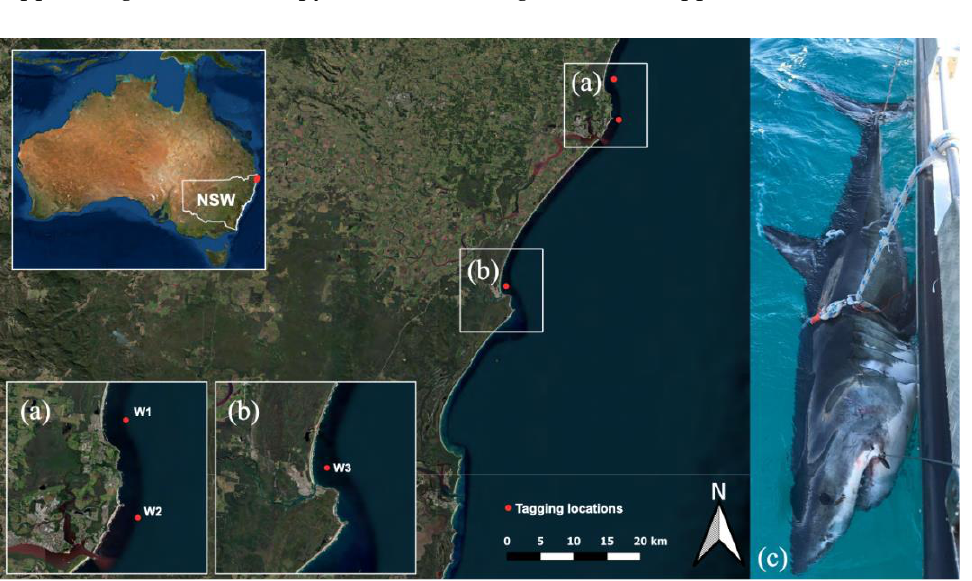
Figure 1. Location of tagging sites (red dots) on the northern New South Wales coast of eastern Australia. ( a ) Lennox Head, tagging site of white shark 1 (W1) and Ballina, tagging site of white shark 2 (W2), ( b ) Evans Heads, tagging site of white shark 3 (W3), and ( c ) W1 secured to the side of the vessel during tagging procedure (image provided by the New South Wales Department of Primary Industries). Map generated in QGIS.